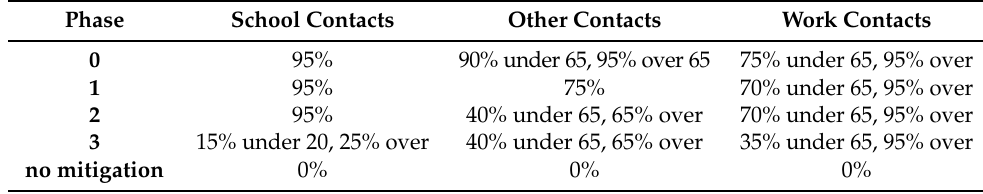
Table A3. Contact mitigation phase description (% reduction in